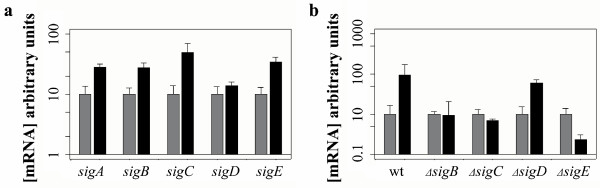
a: Levels of sigma factor mRNAs during nitrogen starvation. Cells were grown under normal (white columns) or nitrogen starved (grey columns) conditions. sig mRNAs were quantified using quantitative RT-PCR. Each sample was measured in triplicate and the standard deviation is indicated by error bars. Values were normalized to the rpoA transcript. The expression of each gene in non starved cells was set equal to 10 (in arbitrary units). b: Effect of sigma mutations on the transcription of glnN gene during nitrogen starvation. mRNAs were quantified using quantitative RT-PCR. Each sample was measured in triplicate and the standard deviation is indicated by error bars. Values were normalized to the rpoA transcript. The expression of glnN gene in non starved cells (white columns) was set equal to 10 (in arbitrary units). The grey bars represented the expression of glnN gene in nitrogen starved cells.